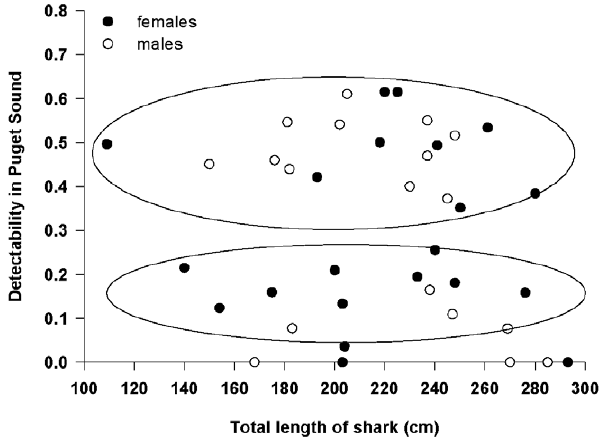
Figure 3. Frequency of detection of sixgill sharks in Puget Sound, WA, USA. Clusters show sharks detected at three different scales. The third cluster of six sharks is not circled because it interferes with the legibility of the x-axis.